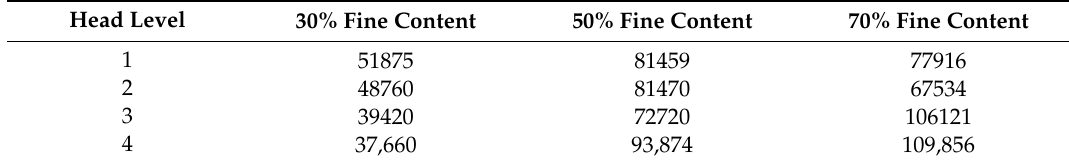
Table 21. Fine particle content change during seepage (20–40 µ m).